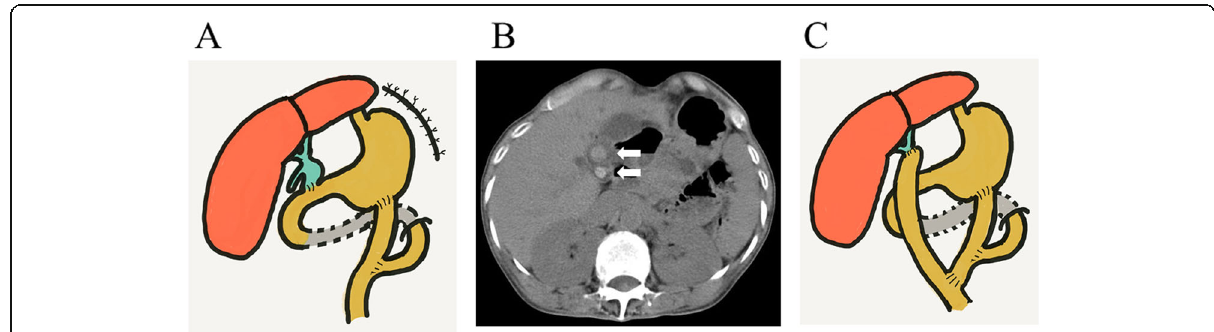
Fig. 2 a The gastrojejunostomy was restored in a Roux-en-Y fashion at 31 years of age. Diaphragmatic plication was also performed. b Computed tomography scan shows gallstones at the porta hepatis at 54 years of age. White arrows: gallstones. c The cystic bile duct and gallbladder were resected. Additionally, biliary reconstruction was performed by hepaticojejunostomy in a Roux-en-Y